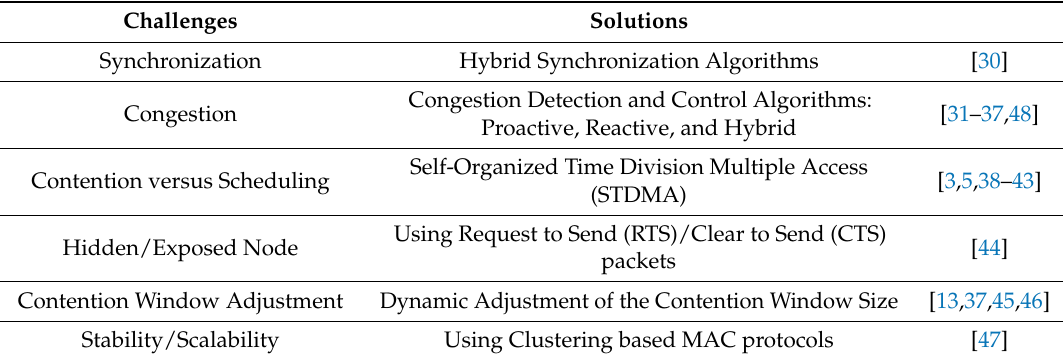
Table 2. Medium Access Control (MAC)